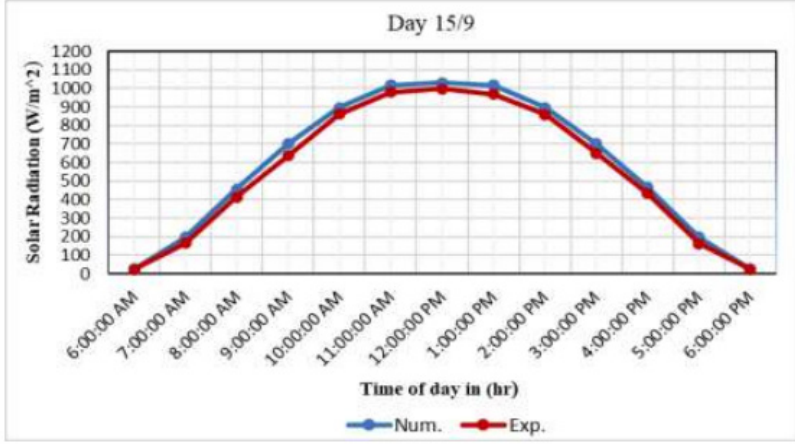
Figure 5. Numerical variation of solar radiation during specific day, site of Baghdad